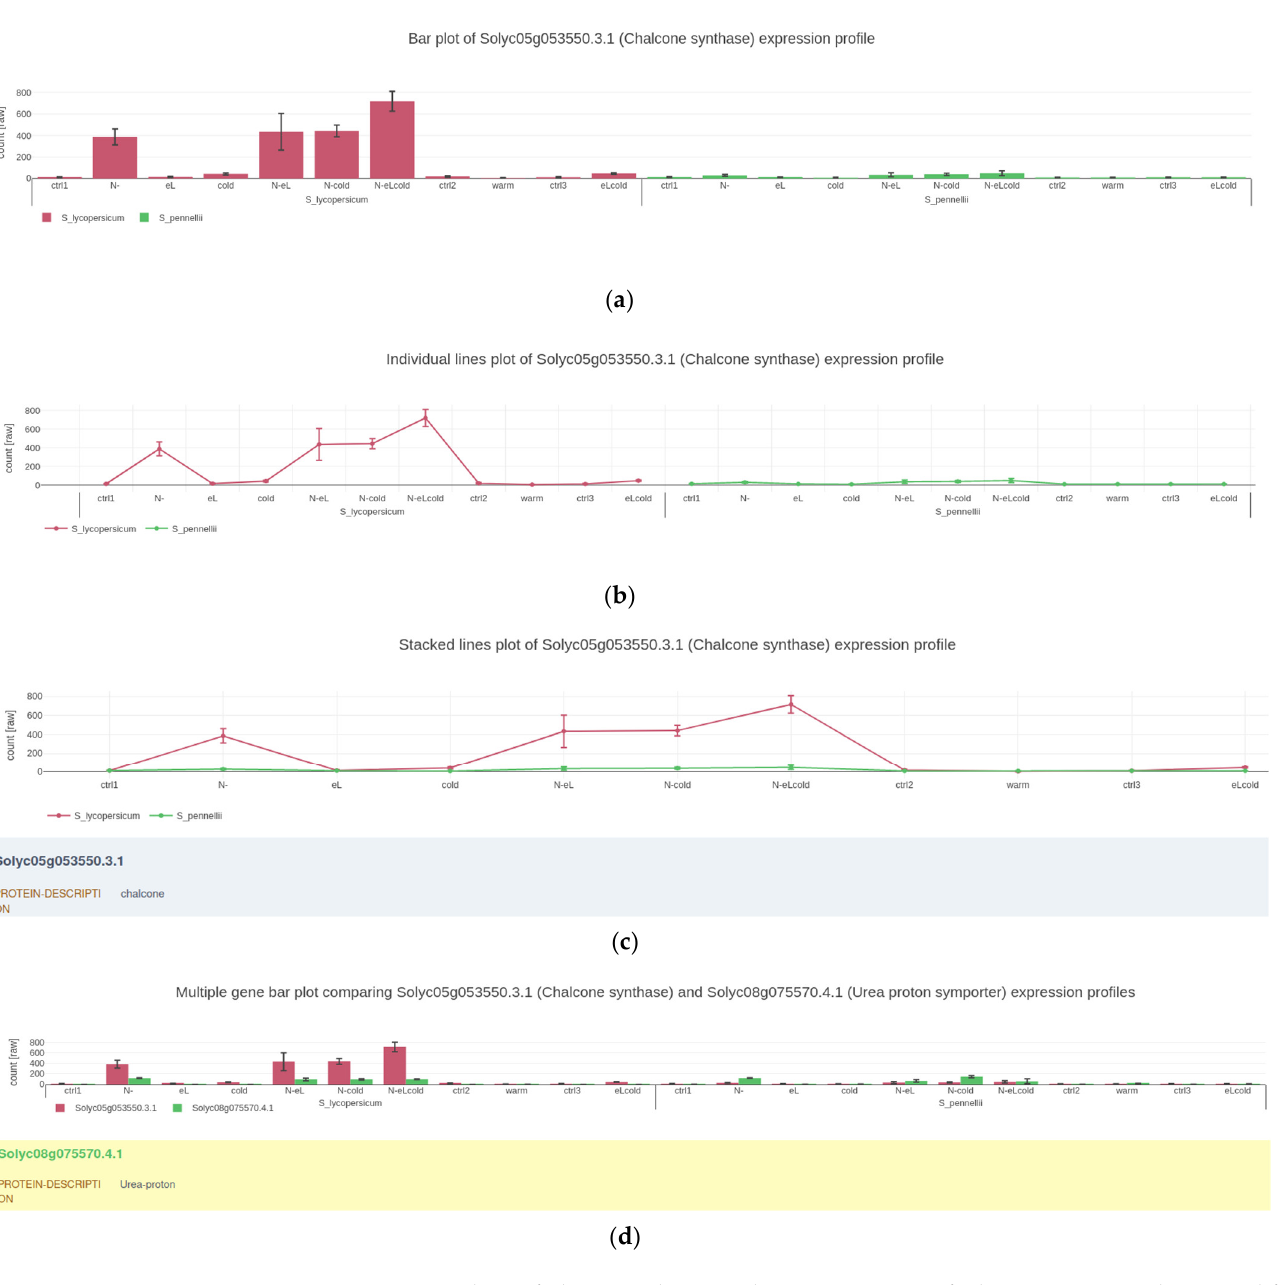
Figure 2. Screenshots of plots visualizing and comparing quantified gene expression between different treatments, experimental conditions, and genes: ( a ) bar plot, ( b ) individual lines plot and ( c ) stacked lines plot, are different modes of how Gene Expression Plotter (GXP) visualizes the expression profile of the example gene Solyc05g053550.3.1 ( CHALCONE SYNTHASE ). The three